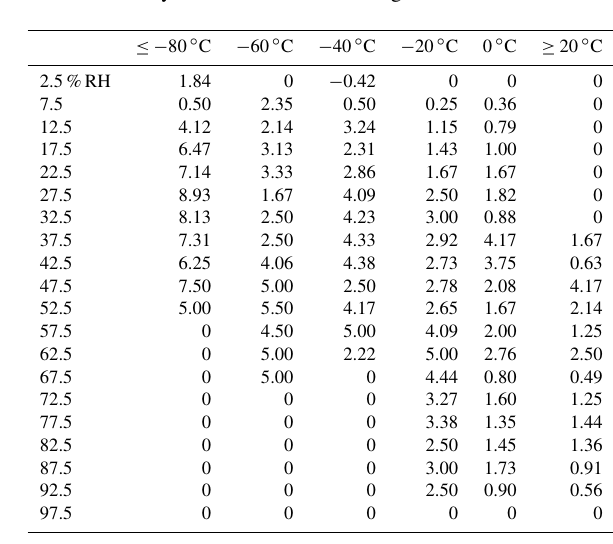
Table 5. Bias correction table of relative humidity that was created by matching the CDFs from the RS92 data to the RS41 data (%RH) based on the daytime data obtained during the MR15-04